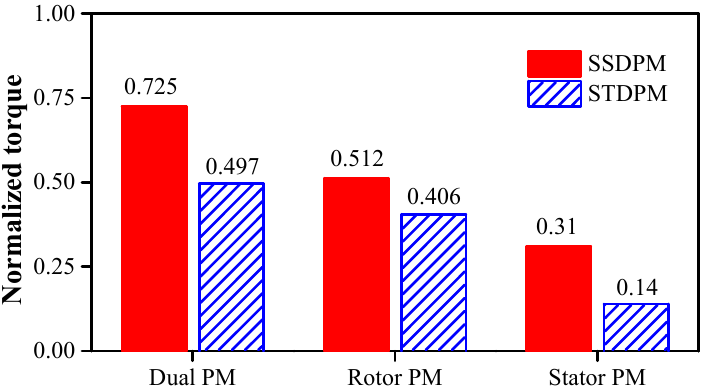
Figure 23. Torque decomposition of two dual-PM machines using frozen permeability method.